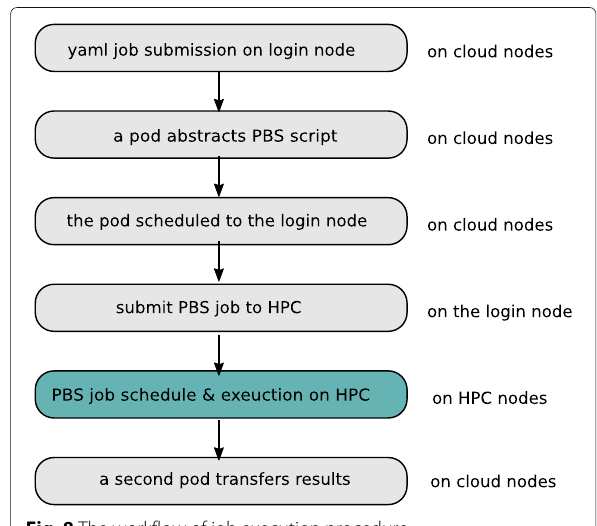
Fig. 8 The workflow of job execution procedure